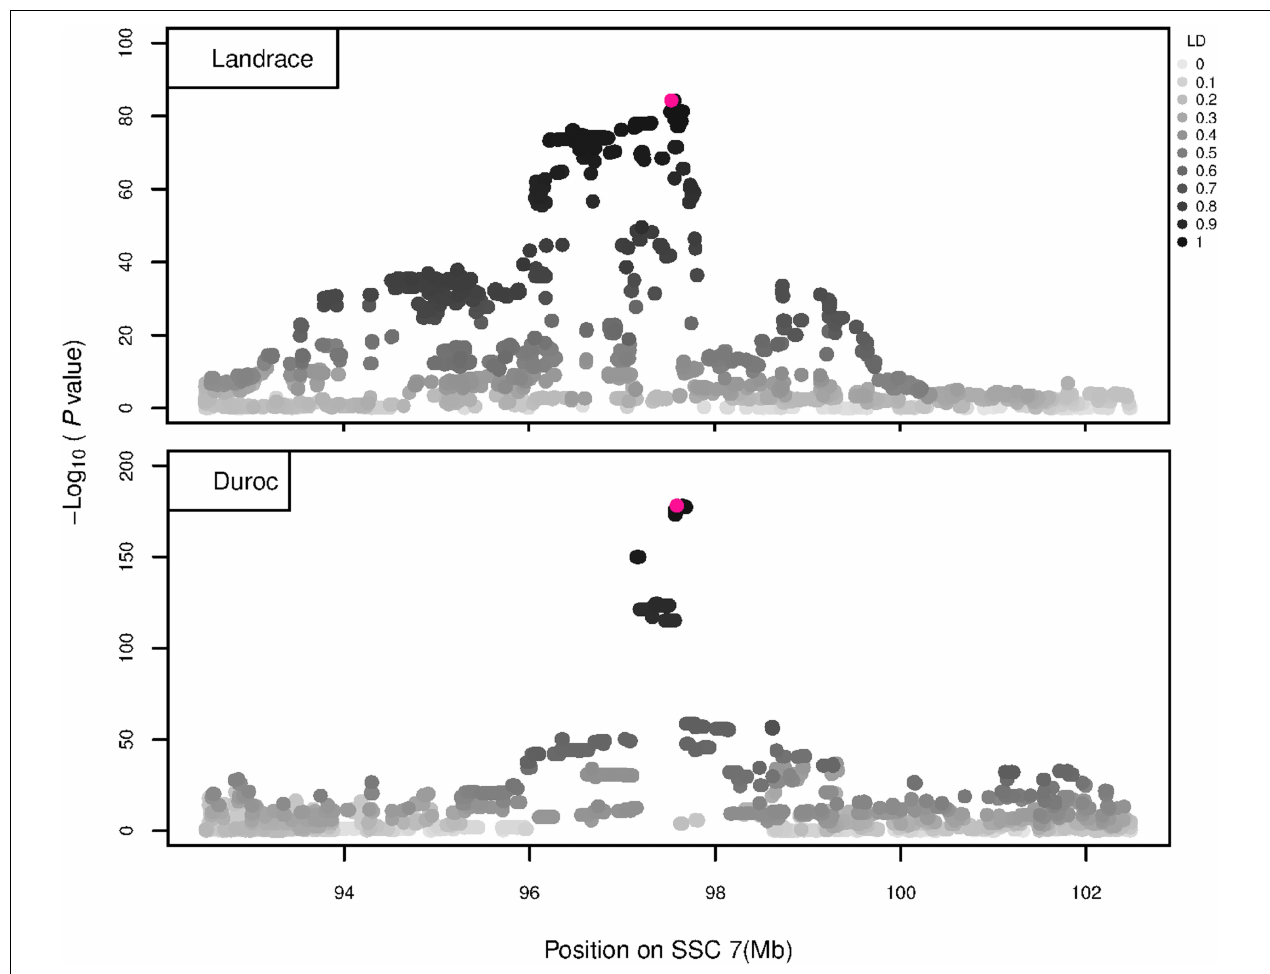
FIGURE 6 | GWAS plot for NVE using imputed whole-sequence data. On the y -axis is the –log 10 ( p -values) of single SNP association with NVE in L and D breeds. On the x -axis is the physical position of the SNP in the SSC7 QTL region. Linkage disequilibrium (LD) is given in a scale of 0–1 as a measure of the pairwise correlation between the most significant SNP (pink dot) and all other